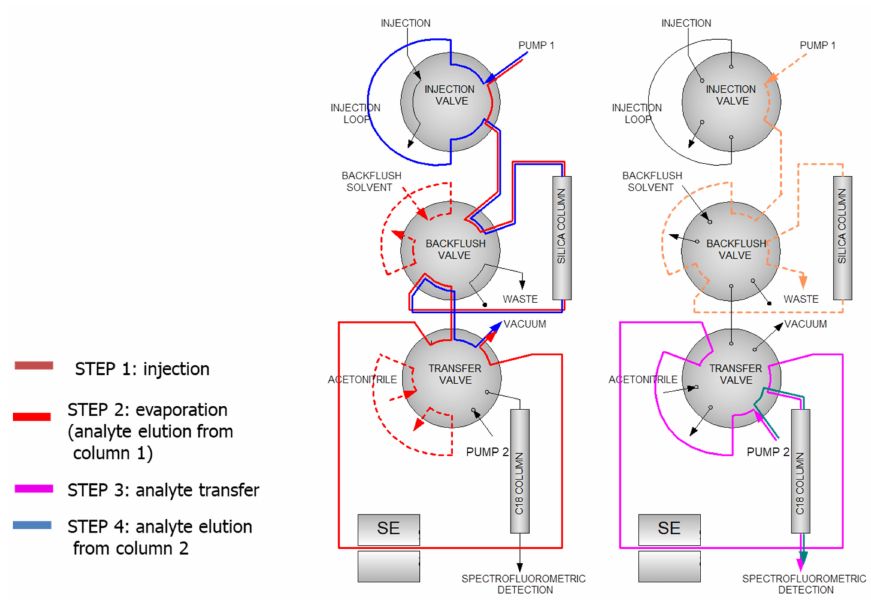
Figure 5. Valve configuration for on-line RPLC-LC determination of heavy